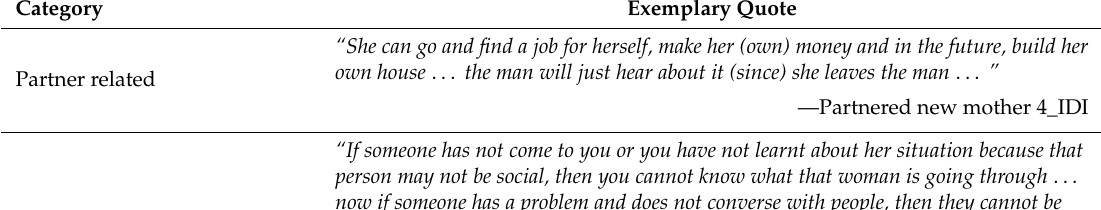
Table 5. Classification and examples of associated help-seeking behaviours and management for